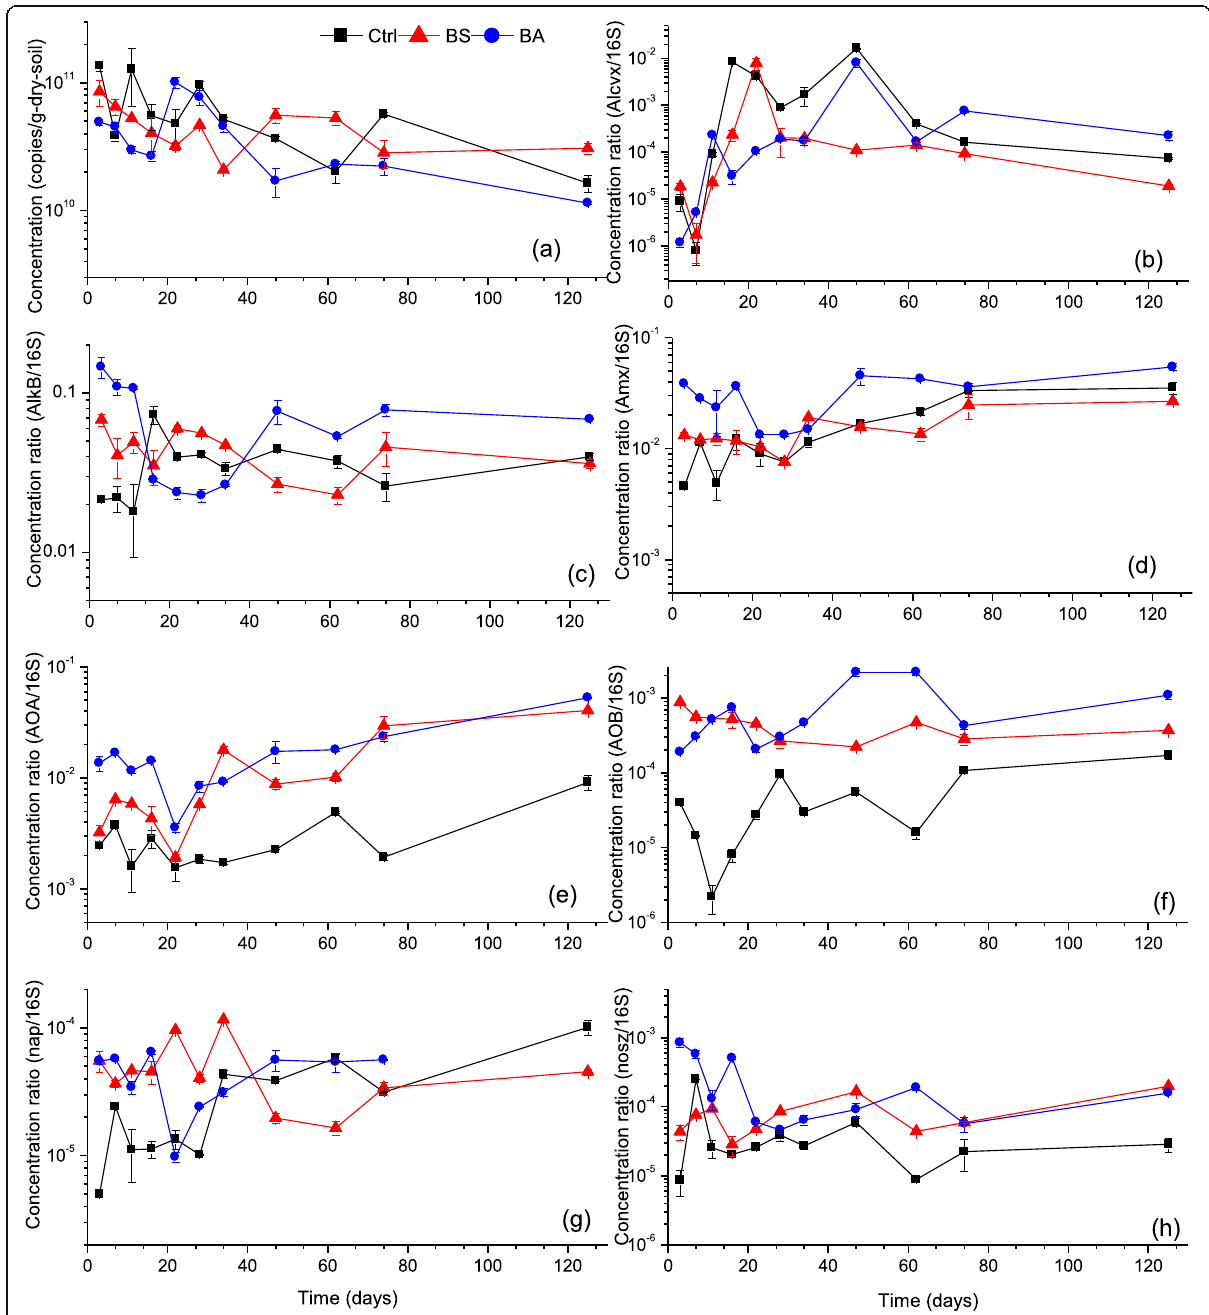
Fig. 3 Variations in a 16S rRNA gene concentrations and b – h the concentration ratios ( R ) of functional genes to 16S rRNA genes with remediation time in the Ctrl, BS, and BA blocks. Error bars present the standard deviation (SD) of test results ( n =